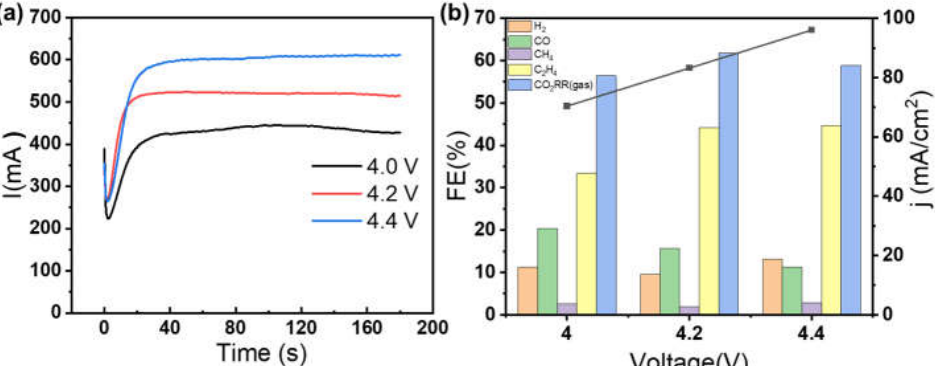
Figure 6. ( a ) I–t curve at different voltages; ( b ) the Faraday efficiency of gas products and current density at different voltages. Operating parameter: CO 2 gas flow rate of 20 sccm, anolyte flow rate of 10 sccm, the anion exchange membrane of Sustainion X37-50 Grade T, and the channel type of parallel microchannel